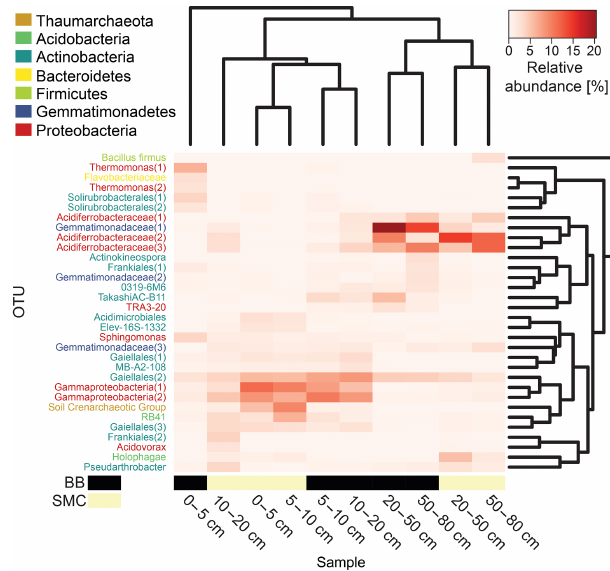
Figure 5. Heatmap based on the relative abundances of the observed operational taxonomic units (OTUs) in soil profiles from Brandy Bay (BB) and Santa Martha Cove (SMC) on James Ross Island, Antarctica. Only OTUs with a relative abundance of at least 3% in a given sample were included. Samples as well as OTUs were clustered using average linkage hierarchical